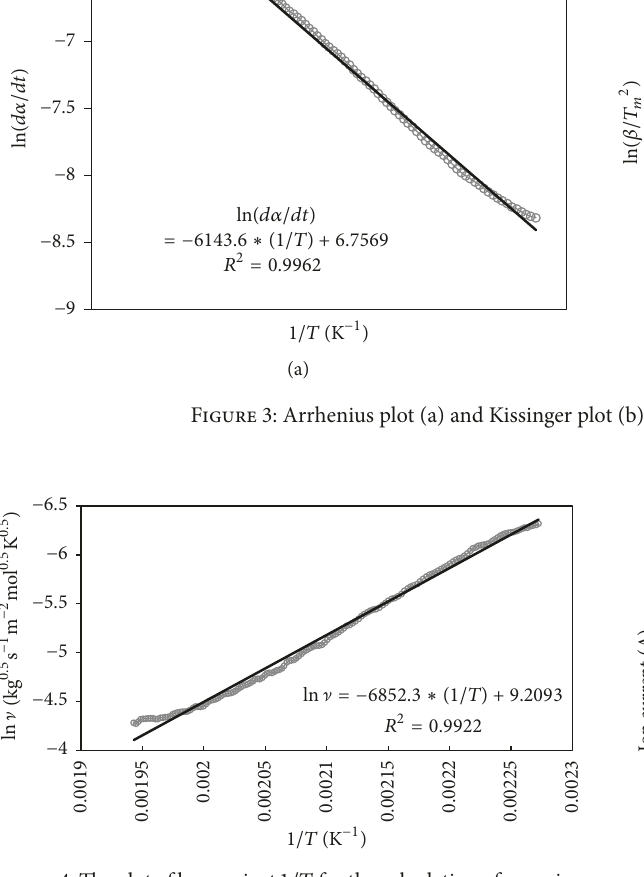
Figure 4: The plot of ln ] against 1/𝑇 for the calculation of vaporiza- tion enthalpy.